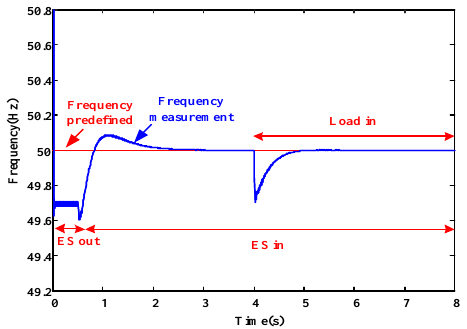
Figure 10. Simulation results of frequency control for a single ES.